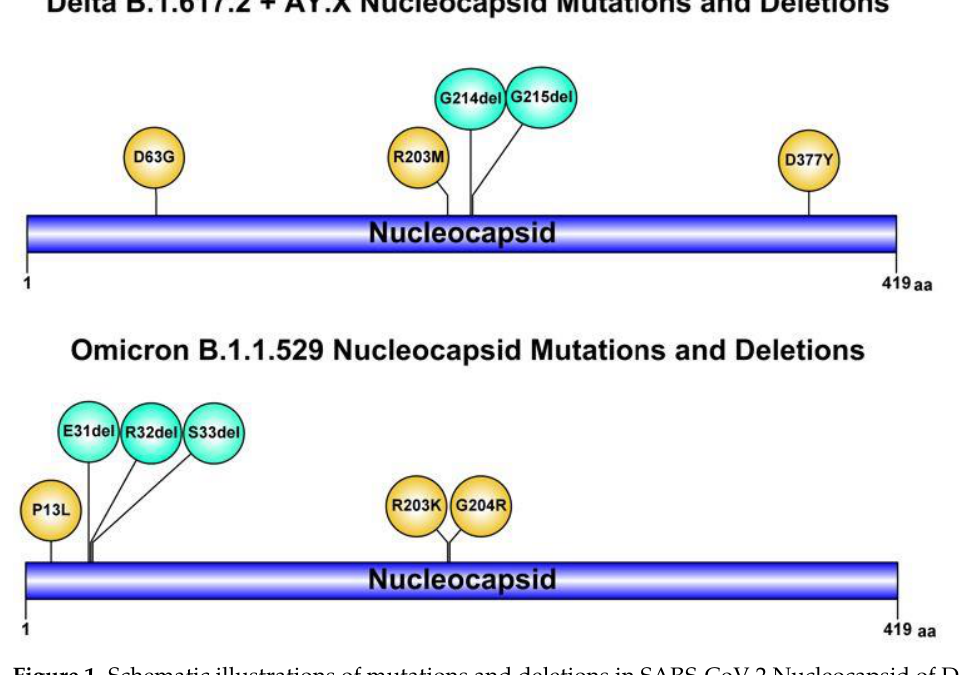
Figure 1. Schematic illustrations of mutations and deletions in SARS-CoV-2 Nucleocapsid of Delta and Omicron variants of concern, which may deceive diagnostic assays (created using graphical IBS 1.0.3 software).